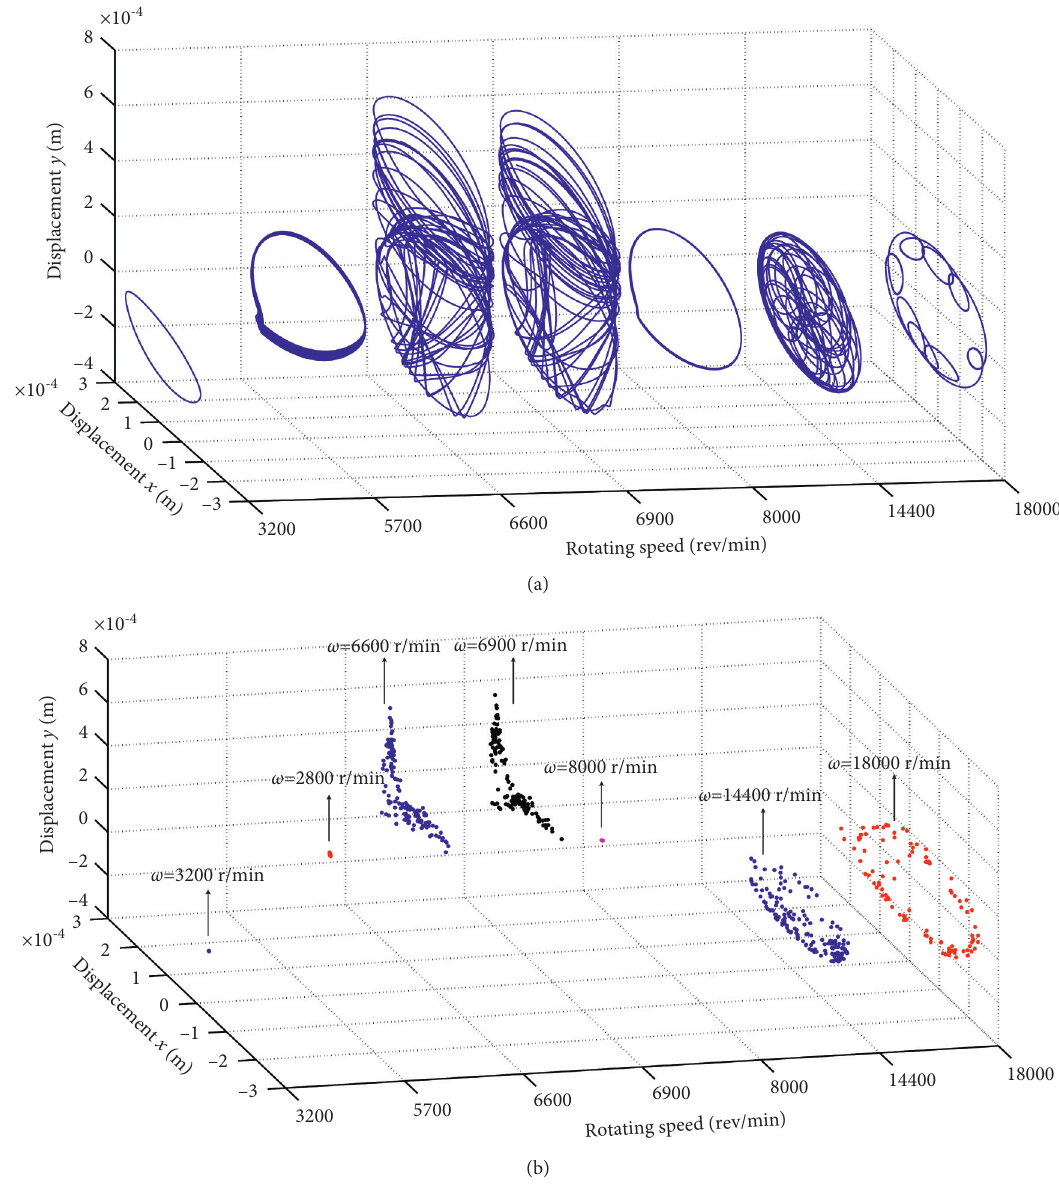
Figure 7: Rotor orbits and Poincar´e maps of the right journal. (a) Rotor orbits. (b) Poincar´e